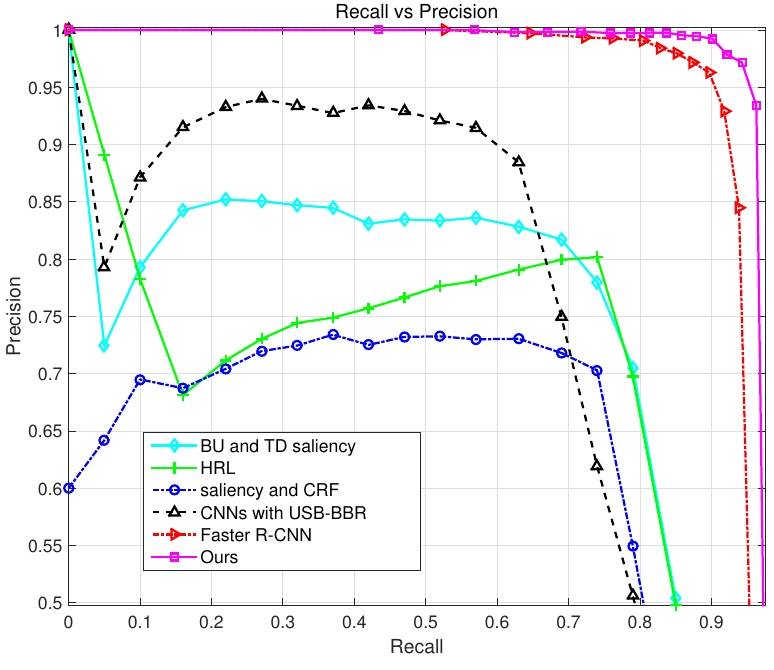
Figure 11. Comparison of the different airport detection methods.